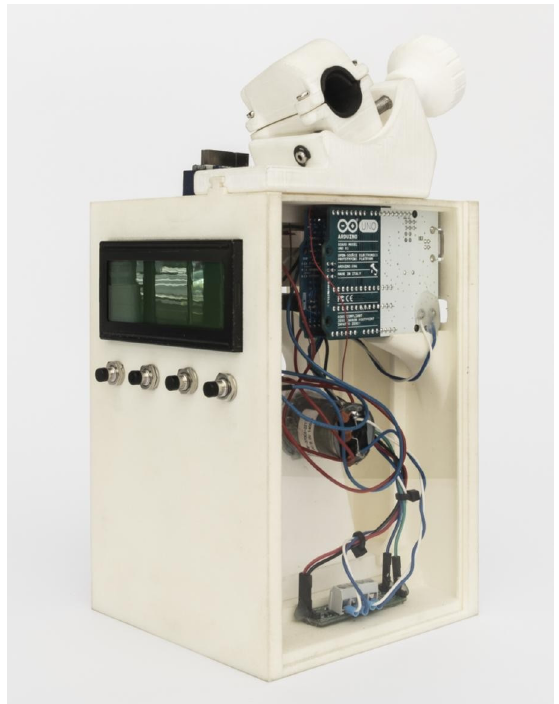
Figure 1. Design of prototype based on 2D/3D CAE (computer-aided engineering) (Midas FX, Brunleys, Milton Keynes, UK) software and parts of the hardware of the cyclic fatigue test device.